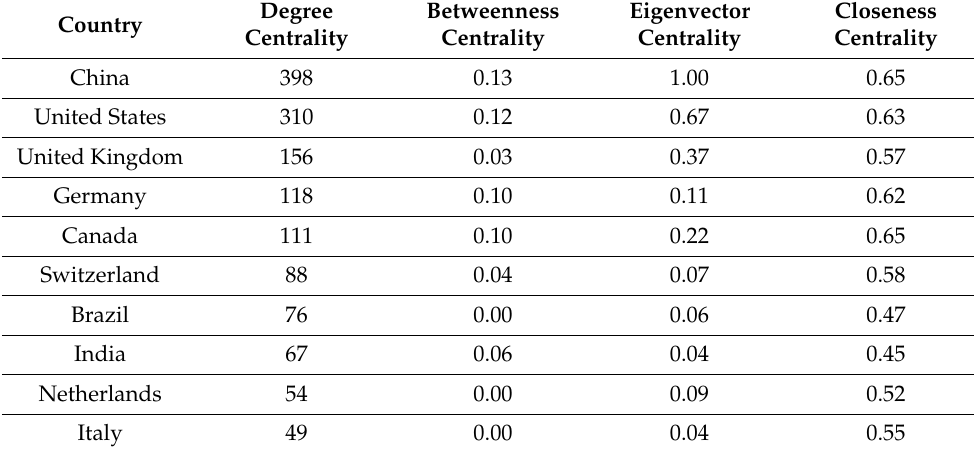
Table 14. Centrality measures of countries involved in co-authorship networks.